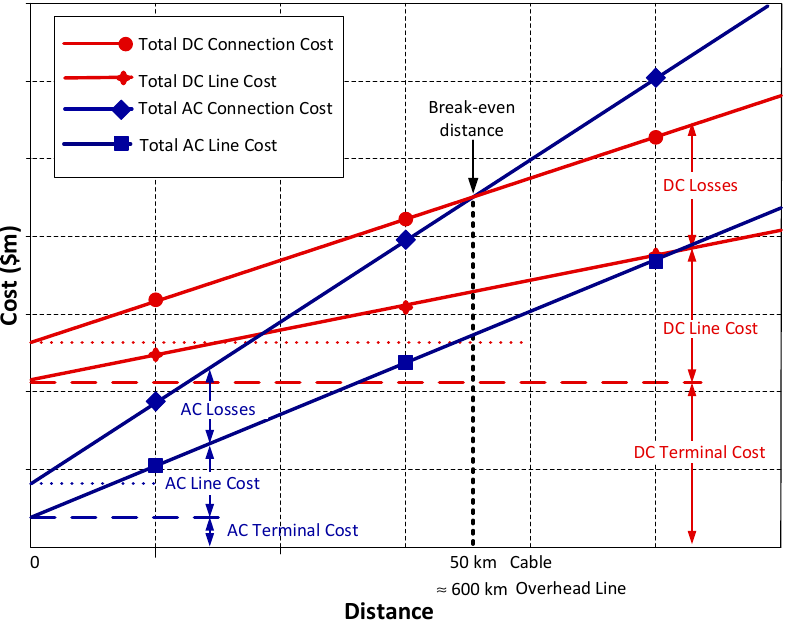
Figure 2. Comparative cost of AC and DC transmission systems.